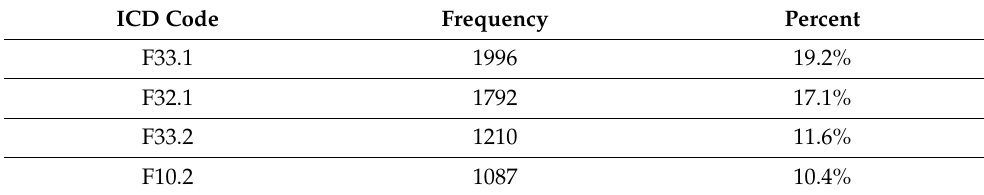
Table 3. Frequencies of ICD Codes in the non-foehn discharge group.